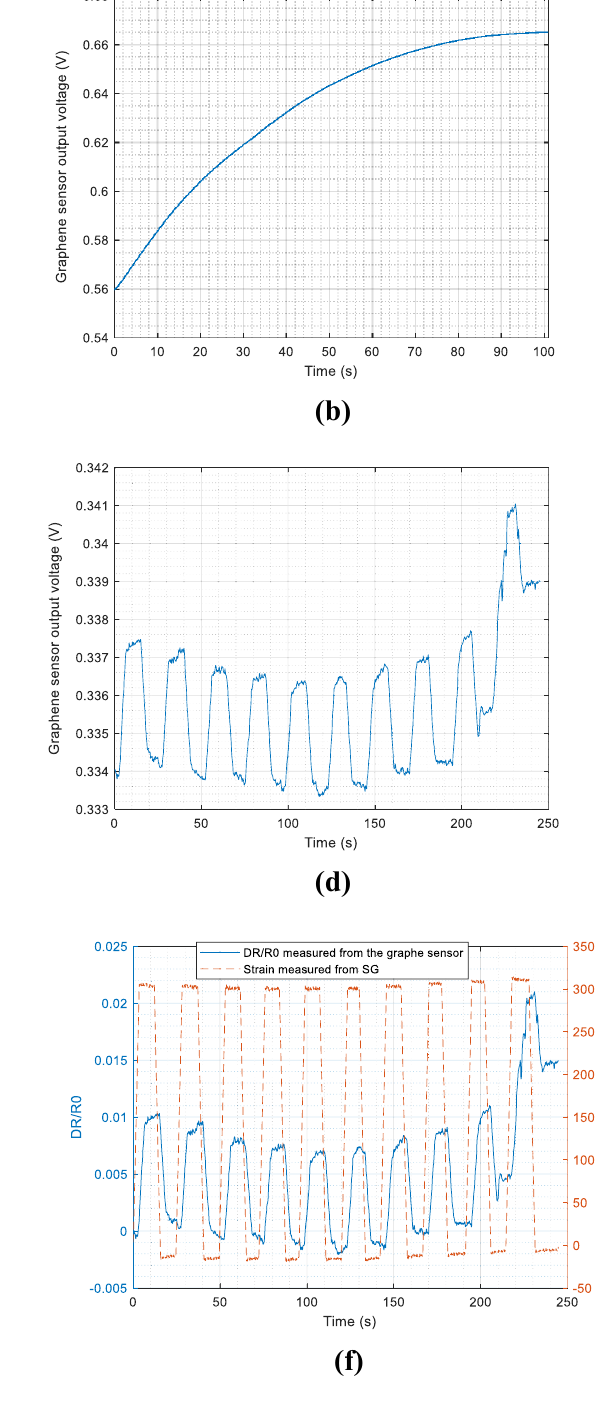
strain sensor to strain measurement obtained from strain gauge under e normal tensile load and f 10 cycles cyclic tensile